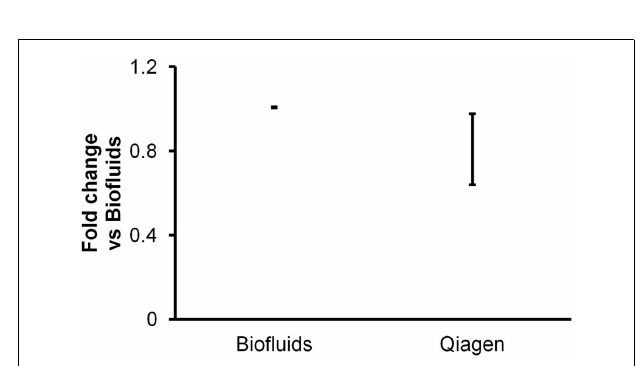
FIGURE 3 | Comparison of two biofluids-specific kits .Triplicate plasma RNA isolations with Exiqon Biofluids and Qiagen miRNeasy Serum/Plasma (glycogen added for both) were compared in triplicate RT-qPCR reactions for two endogenous and one spiked-in miRNA. Fold abundance is relative to Exiqon Biofluids. Note that for the Exiqon and Qiagen kits, the eluate volumes were 50 and 14 µ l, respectively, as specified by the manufacturers’ protocols, so the results are not necessarily directly comparable (see